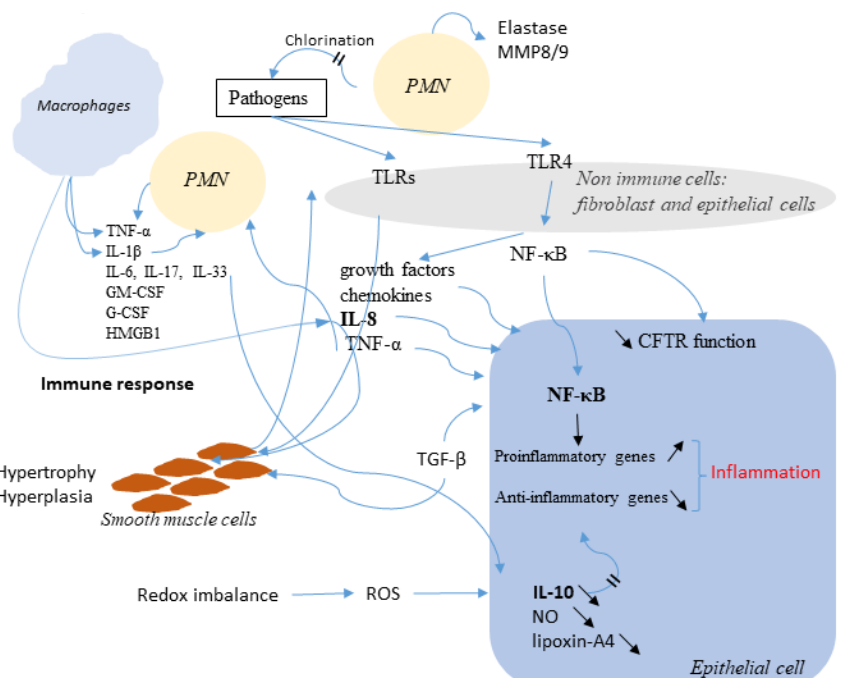
Figure 5. Schematic representation of the link between infection, inflammation, and CFTR. Immune cells release many factors, such as TNF- α , IL-1 β , IL-8, IL-4, IL-13 and IL-10 in order to eradicate pathogens. Among the secreted molecules, some are pro-inflammatory like Il-8 and TNF- α . NF- κ B is activated. The altered function of CFTR is also involved and is accompanied by an increased expression of NF- κ B which activates inflammatory genes. The Redox imbalance also takes part in the activation of the inflammatory response.